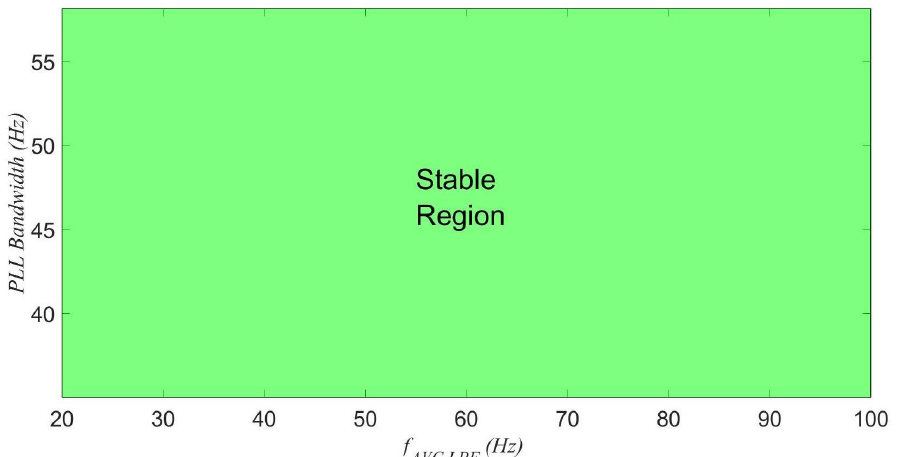
Figure 13. Stability regions of PLL bandwidth in strong grid case (SCR = 10), when f AVC,LPF varies from 20 to 100 Hz. The system is stable for the PLL bandwidth in question; therefore, no critical oscillation frequencies are